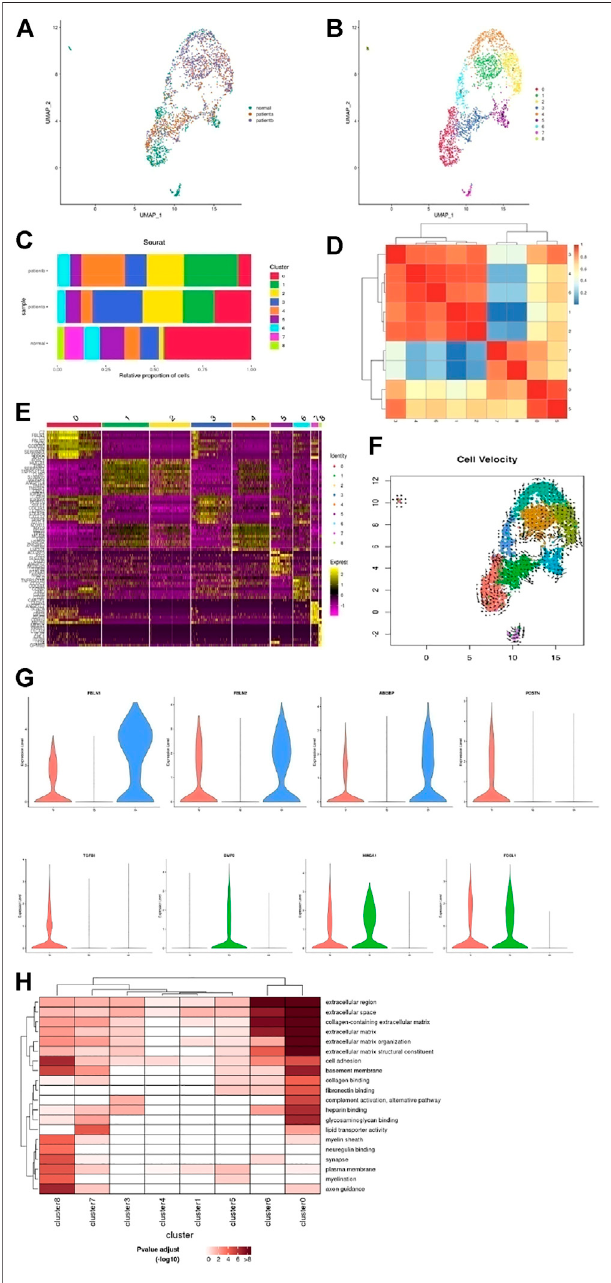
FIGURE 4 | Heterogeneity of fi broblast cells in human ascending thoracic aortic walls. (A) UMAP plot of fi broblast cells colored according to identi fi ed clusters. (B) Nine subclusters of T cells were identi fi ed and color- coded as shown in the UMAP plot. (C) The cell composition proportion of fi broblast subclusters. (D) Correlation analysis of T cell subclusters. (E) Heatmapshowingthetop fi vegenesandtheirrelativeexpressionineachsub- cluster of fi broblast cells. (F) The RNA velocity analysis shows the possible transition between different cluster cells. The arrow shows the direction of transformation. (G) The violin diagram shows some special changed genes in subclusters of diseases. (H) The signi fi cantly changed pathways in each subcluster were shown with GO enrichment analysis. A: disease a, B: disease b, N: normal.